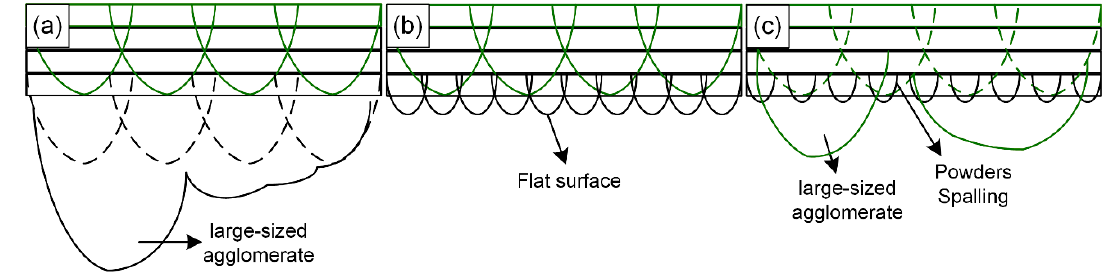
Figure 10. Forming schematic diagram of lower surface: ( a ) high E F ; ( b ) moderate E F ; ( c ) lower E F .